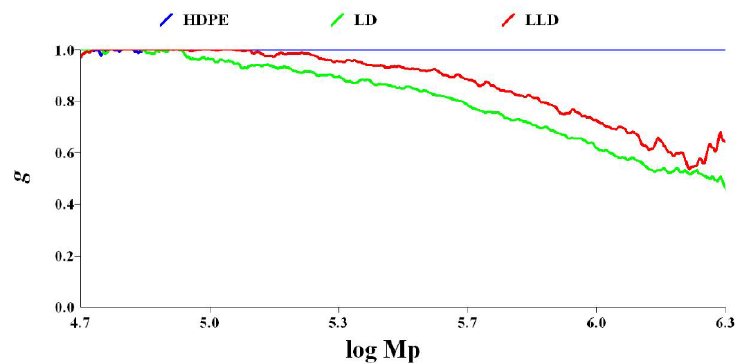
Figure 7. Diagram of g vs. log molecular weight for polyethylenes.